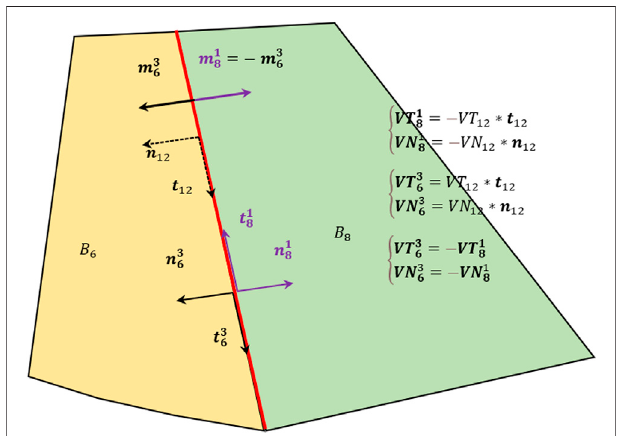
FIGURE 3| Approaches for representing the force on the interface used by two adjacent blocks in common.